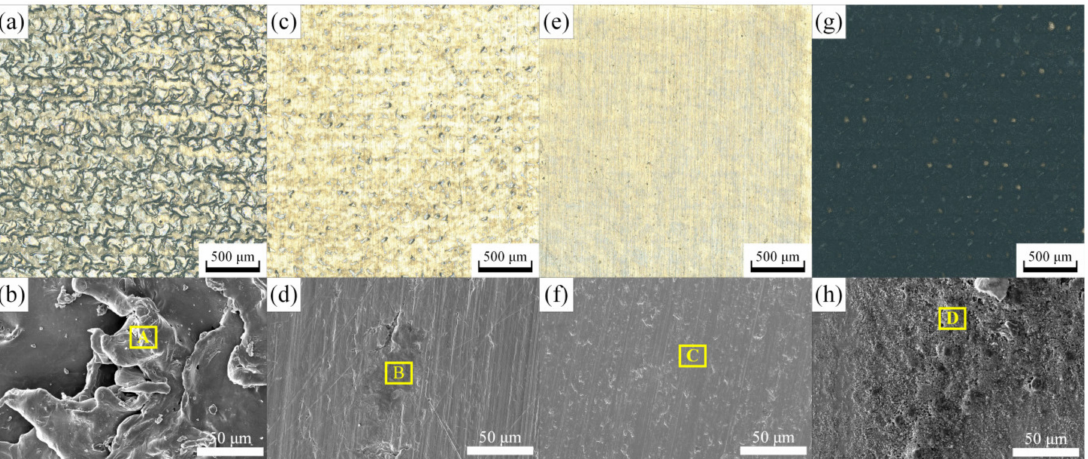
Figure 14. Effect of laser pulse frequency on the surface morphology of the samples. ( a ) Surface morphology at 300 Hz; ( b ) SEM morphology at 300 Hz; ( c ) Surface morphology at 600 Hz; ( d ) SEM morphology at 600 Hz; ( e ) Surface morphology at 900 Hz; ( f ) SEM morphology at 900 Hz; ( g ) Surface morphology at 1200 Hz; ( h ) SEM morphology at 1200